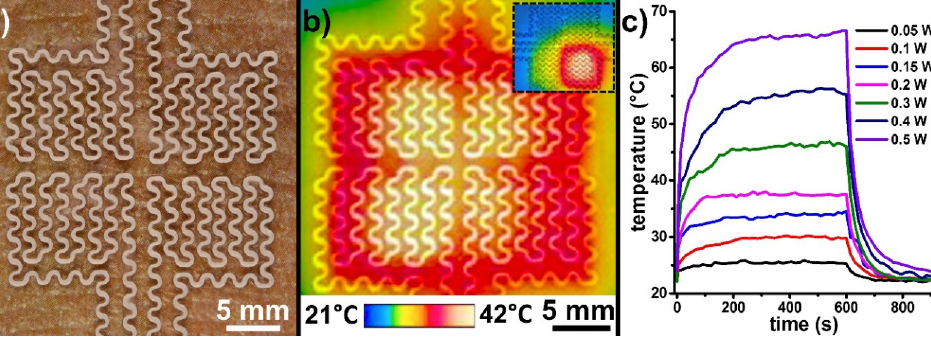
Figure 8. Application of localized heat therapy using razor printed EPEDs: ( a ) Copper-based thermotherapy EPED mounted on skin; ( b ) IR image of the EPED shown in (a) during thermotherapy (inset shows the application of localized heat by the selective activation of only one quadrant of the EPED); ( c ) Temperature-time response of the thermotherapy EPED for different D.C. powers.